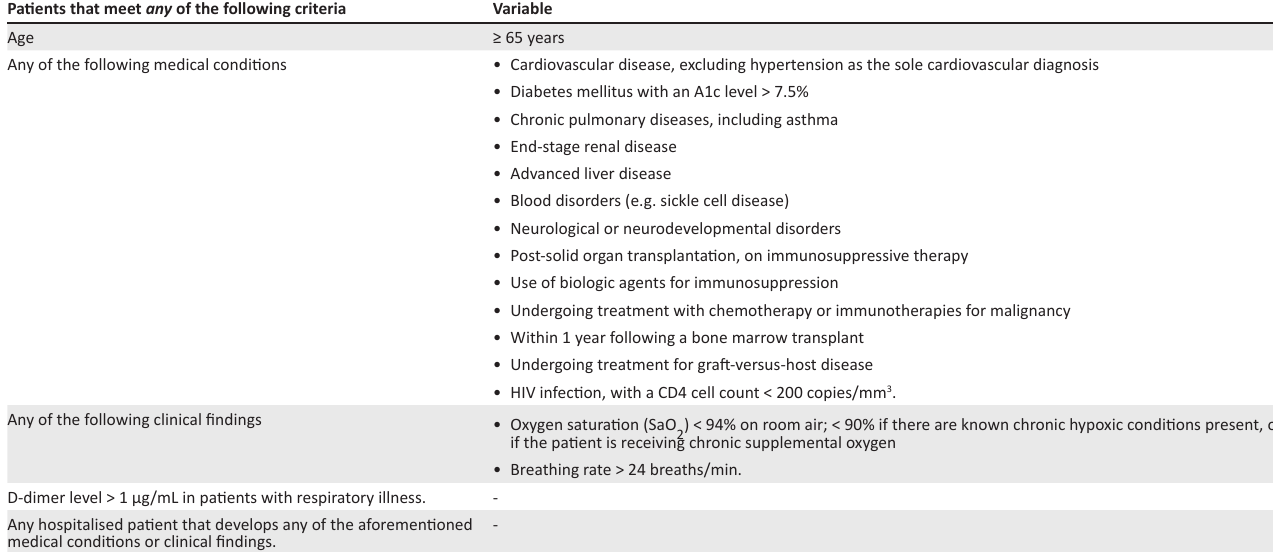
TABLE 2: Criteria for determining which patients are at high risk for poor outcomes. 16 Patients that meet any of the following criteria Variable